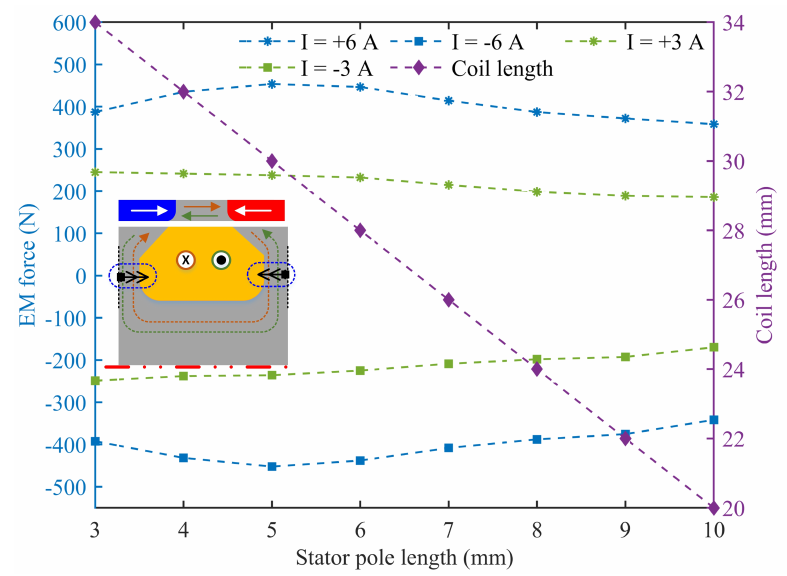
Figure 7. Stator pole length and coil length